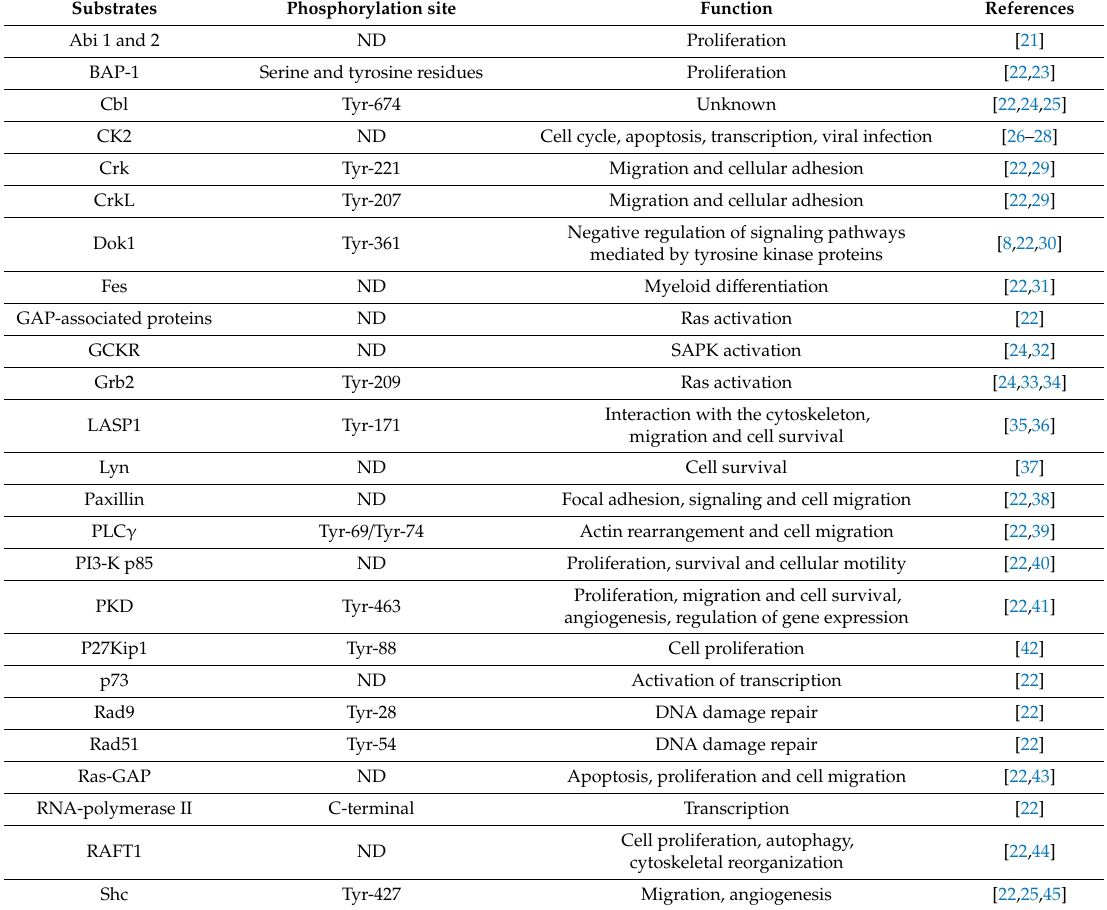
Table 2. BCR-ABL